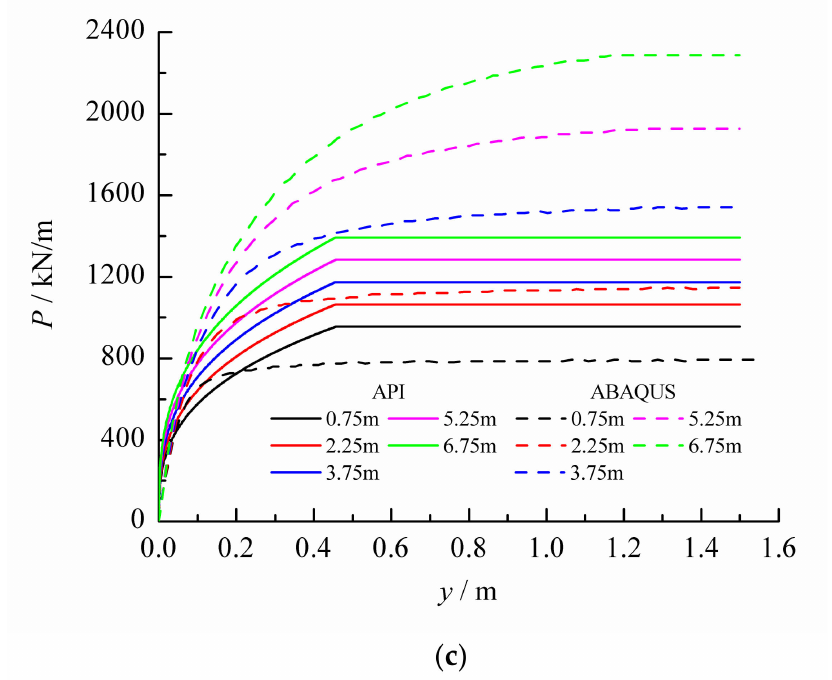
Figure 13. p - y curve of D = 2, 4, 6 m. ( a ) p - y curve of D = 2 m. ( b ) p - y curve of D = 4 m. ( c ) p - y curve of D = 6